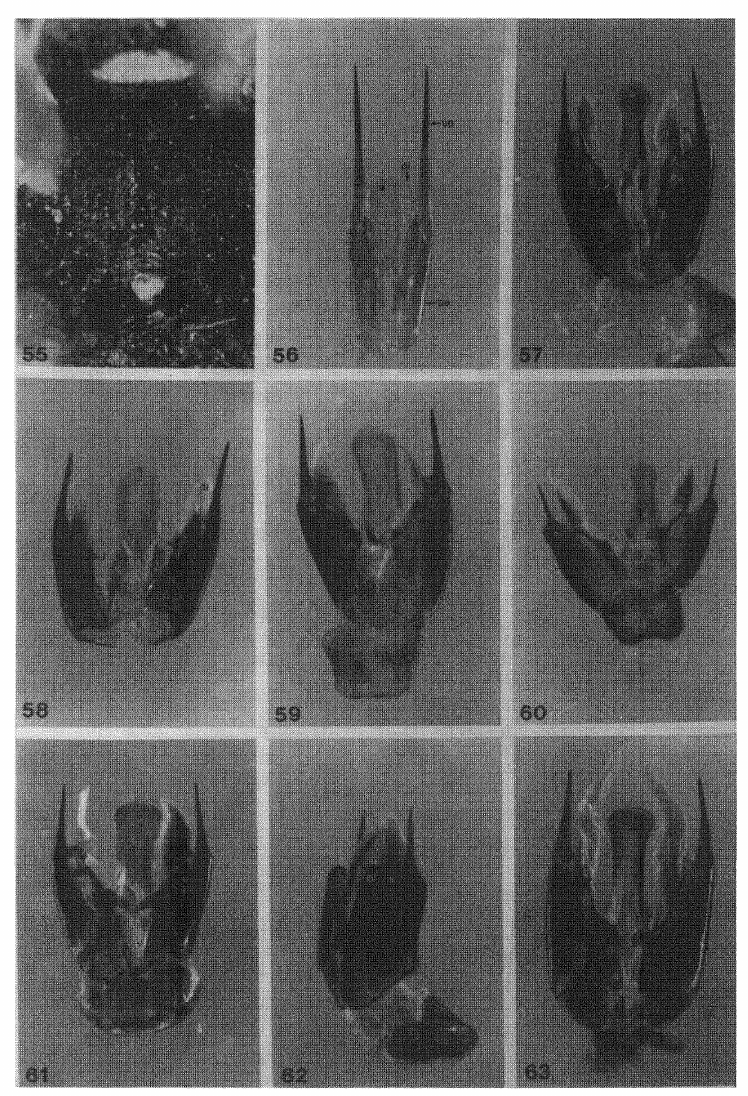
Figs. 55-63. 55. Gayellapatagonica ?, 11)<. Posterodorsal view of propodeum. 56-63. Male genitalia. 56-61. Ventral view. 56. Paramasaris fuscipennis, 26X. 57. G. eumenoides, 17. 58. G. araucana, 21. 59. G. reedi, 18. 60. G.